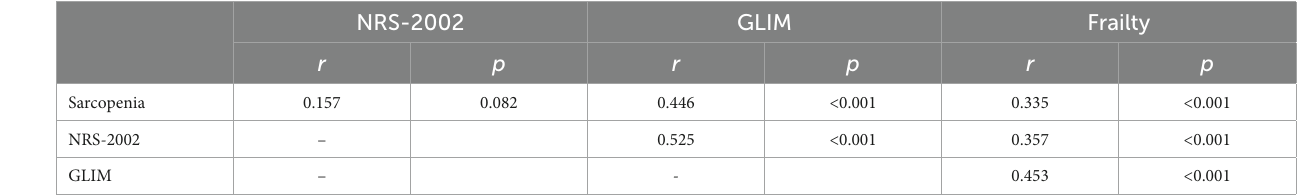
TABLE 3 Correlation among different evaluation criteria.